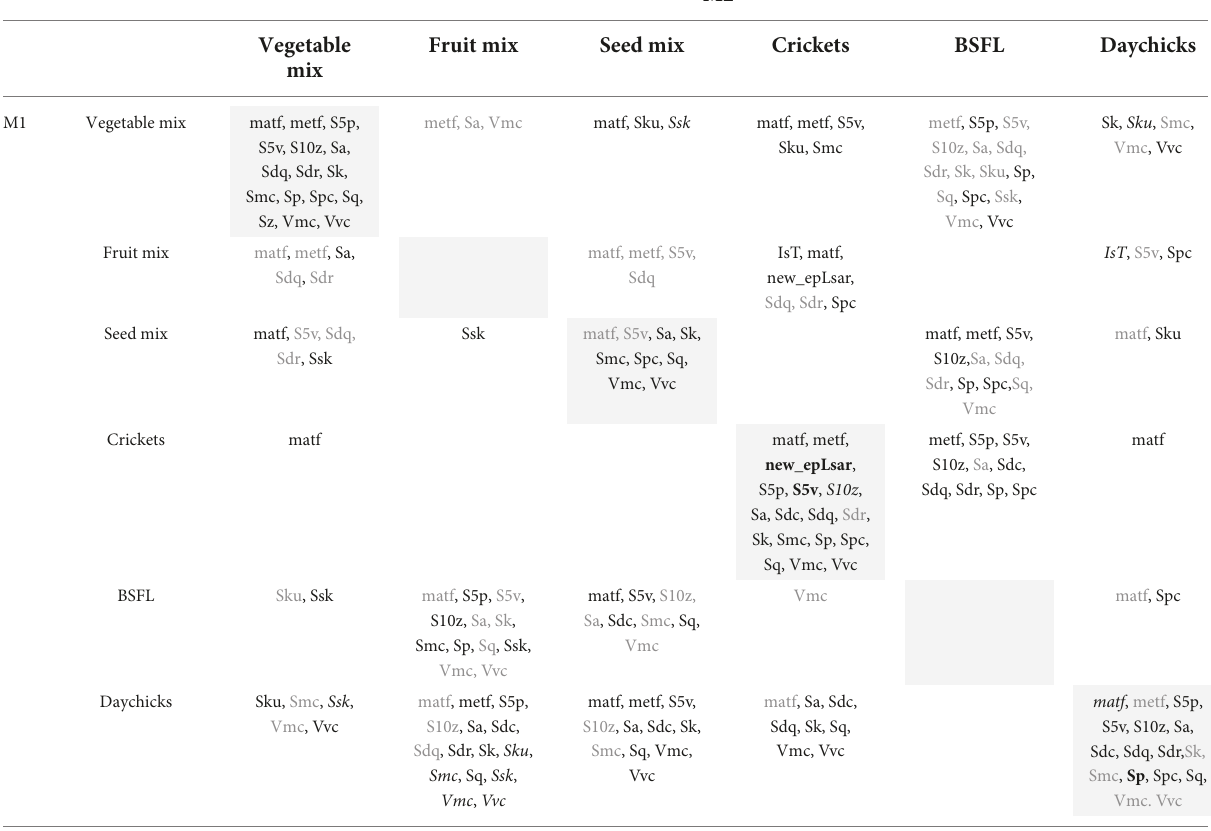
TABLE 2 DMTA parameters displaying significant differences after the application of the Benjamini–Hochberg procedure between diet groups for the same tooth position (white cells) and between tooth positions within the same diet group (gray shaded cells). M2 Fruit